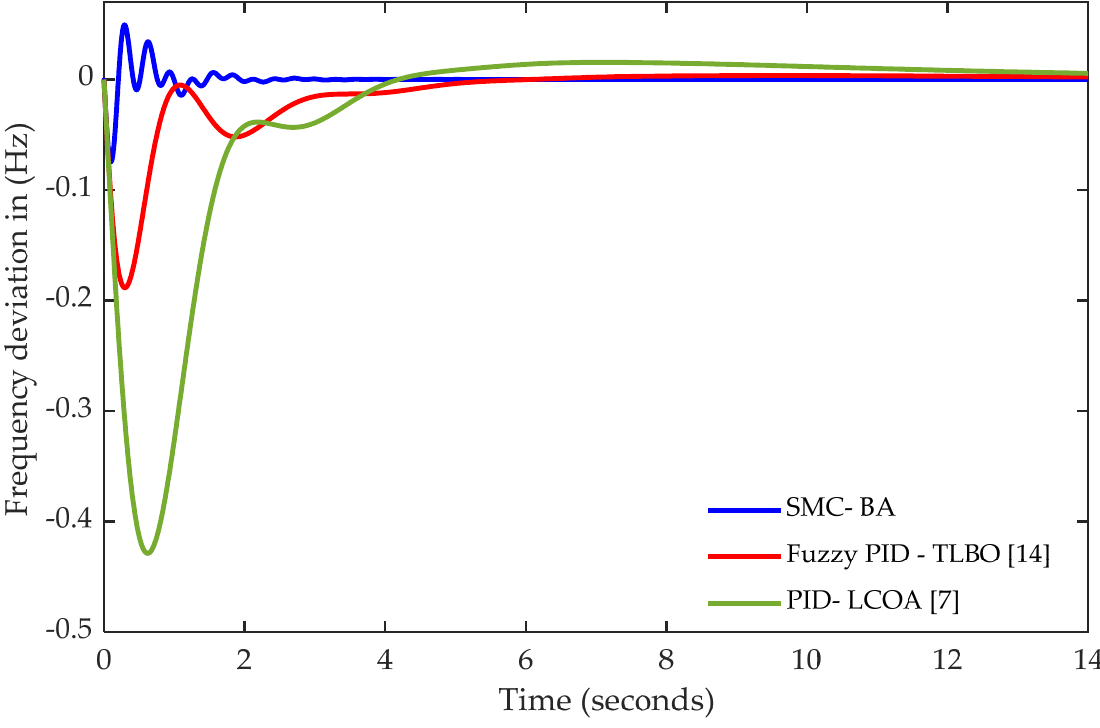
Figure 3. Frequency deviation in area one ( ∆ F 1 in Hz).